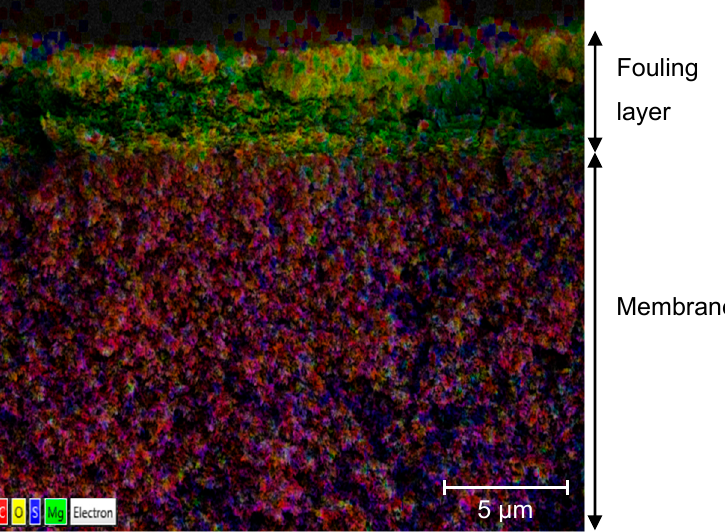
Figure 3. SEM-EDS image of the cross-section of the fouling layer and the active membrane layer of the fouled membrane.